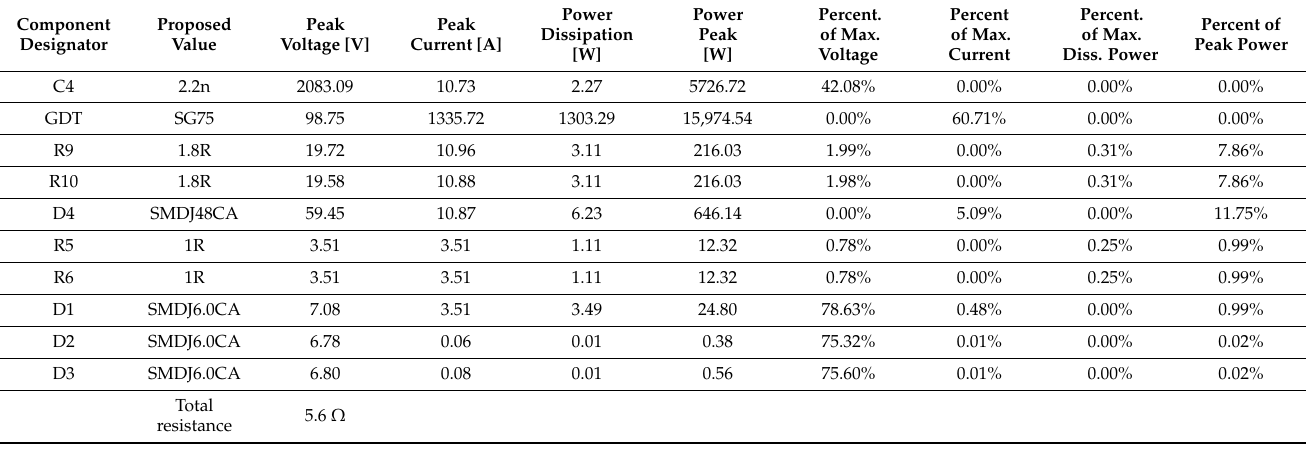
Figure 7. Based on these, the algorithm from the random set of input vectors selects the best individuals and uses them for creating the new, better collection (mean scores of the fitness function are descending).